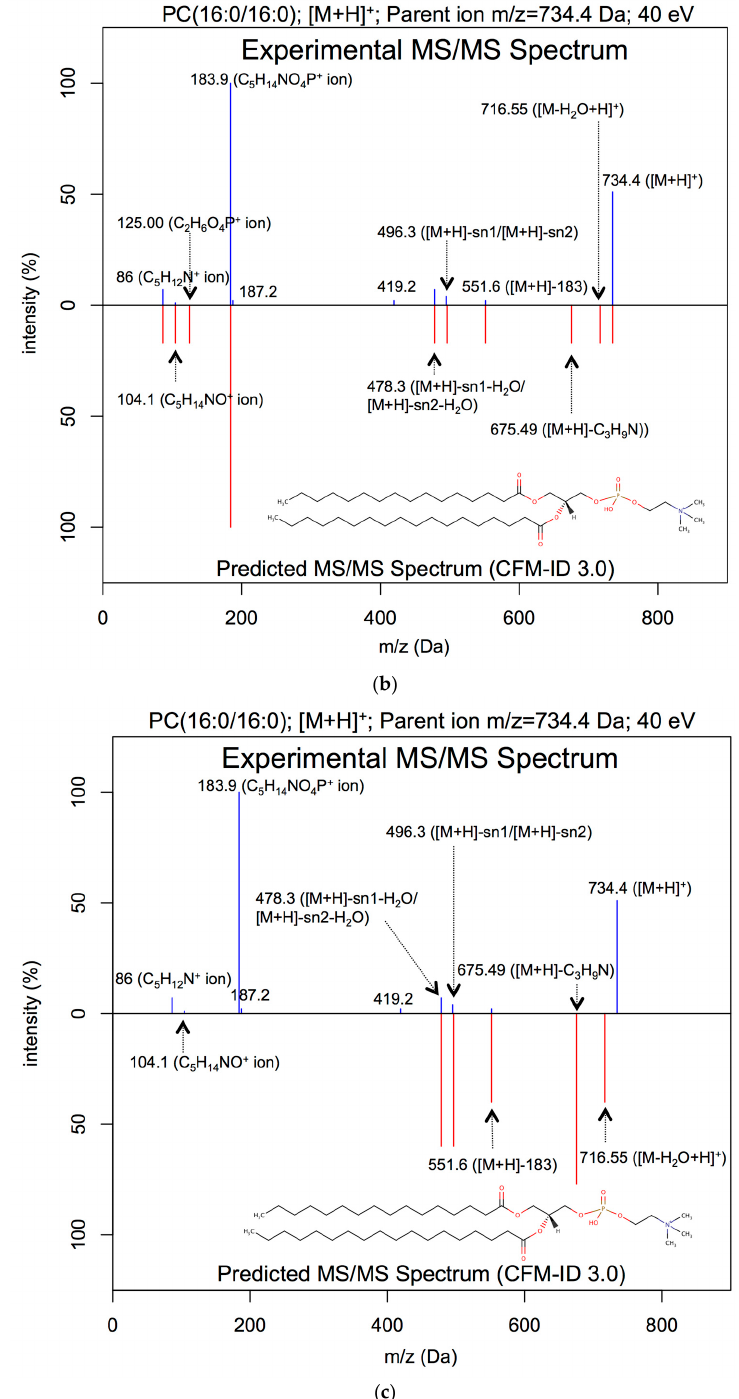
Figure 2. Head-to-tail plot of experimental and predicted electrospray ionization-tandem mass spectroscopy (ESI-MS / MS) spectra of PC(16:0 / 16:0). ( a ) Head-to-tail plot showing an experimental ESI-MS / MS spectrum of dipalmitoyl phosphatidylcholine (PC(16:0 / 16:0)) measured at 40 eV, and the matching ESI-MS / MS spectrum predicted by CFM-ID 2.0. The computed spectral similarity score is 0.07. ( b ) Head-to-tail plot showing an experimental of ESI-MS / MS spectrum of dipalmitoyl phosphatidylcholine measured in positive ion mode ([M + H] + ) at 40 eV, and the matching ESI-MS / MS spectrum predicted by CFM-ID 3.0. The computed spectral similarity score is 0.88. ( c ) Head-to-tail plot showing an experimental of ESI-MS / MS spectrum of dipalmitoyl phosphatidylcholine measured in positive ion mode ([M + H] + ) at 40 eV, and the matching ESI-MS / MS spectrum predicted by LipidBlast. The computed spectral similarity score is